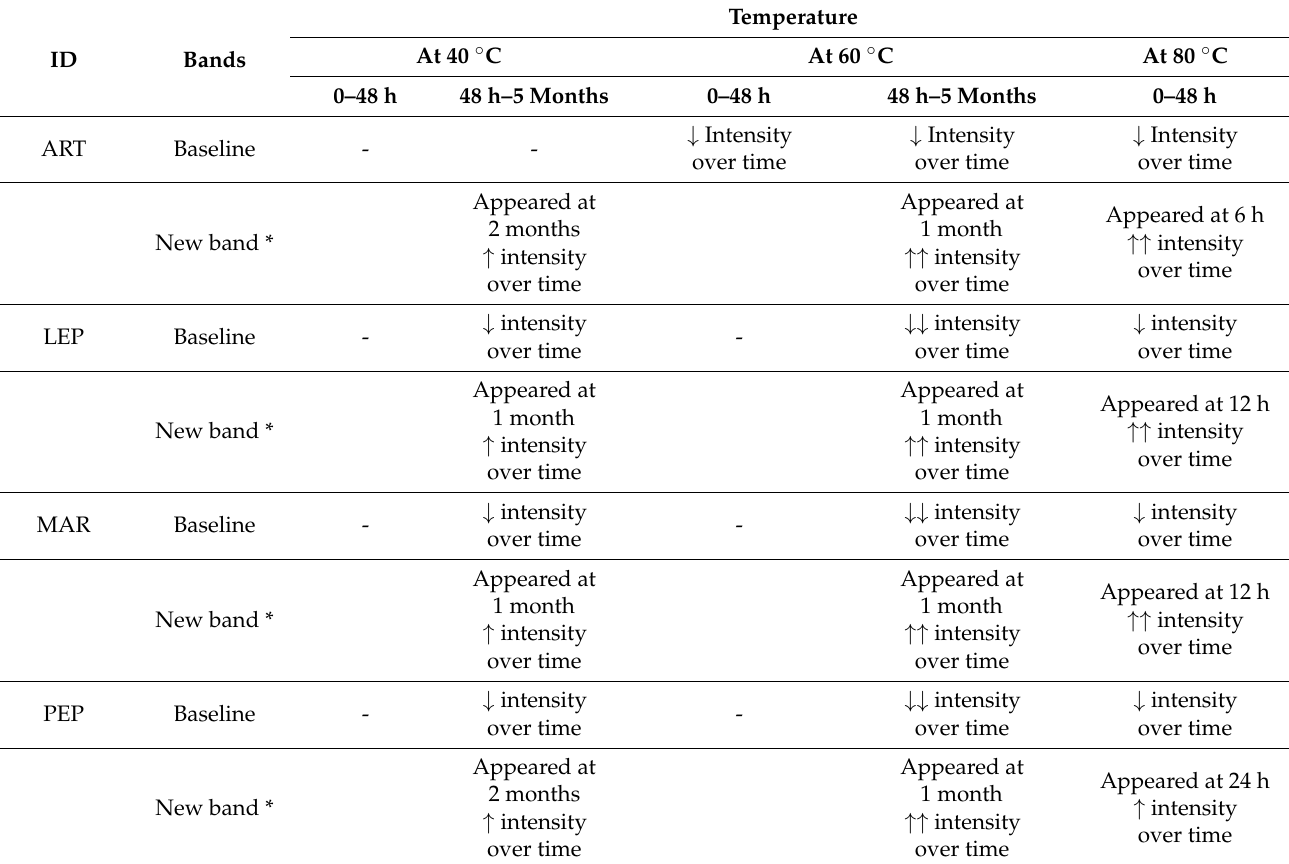
Table 2. Effect of temperature on the HPTLC fingerprints of the